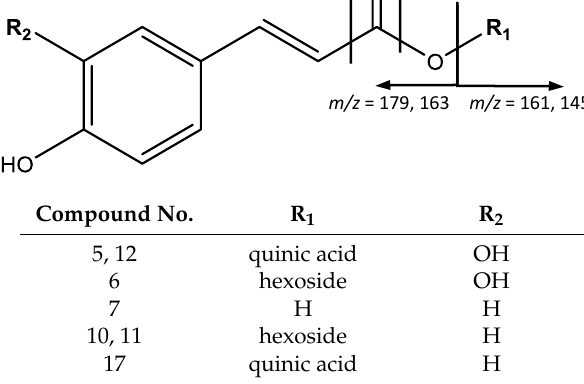
Figure 8. p -coumaric acid derivatives structure and main fragments.